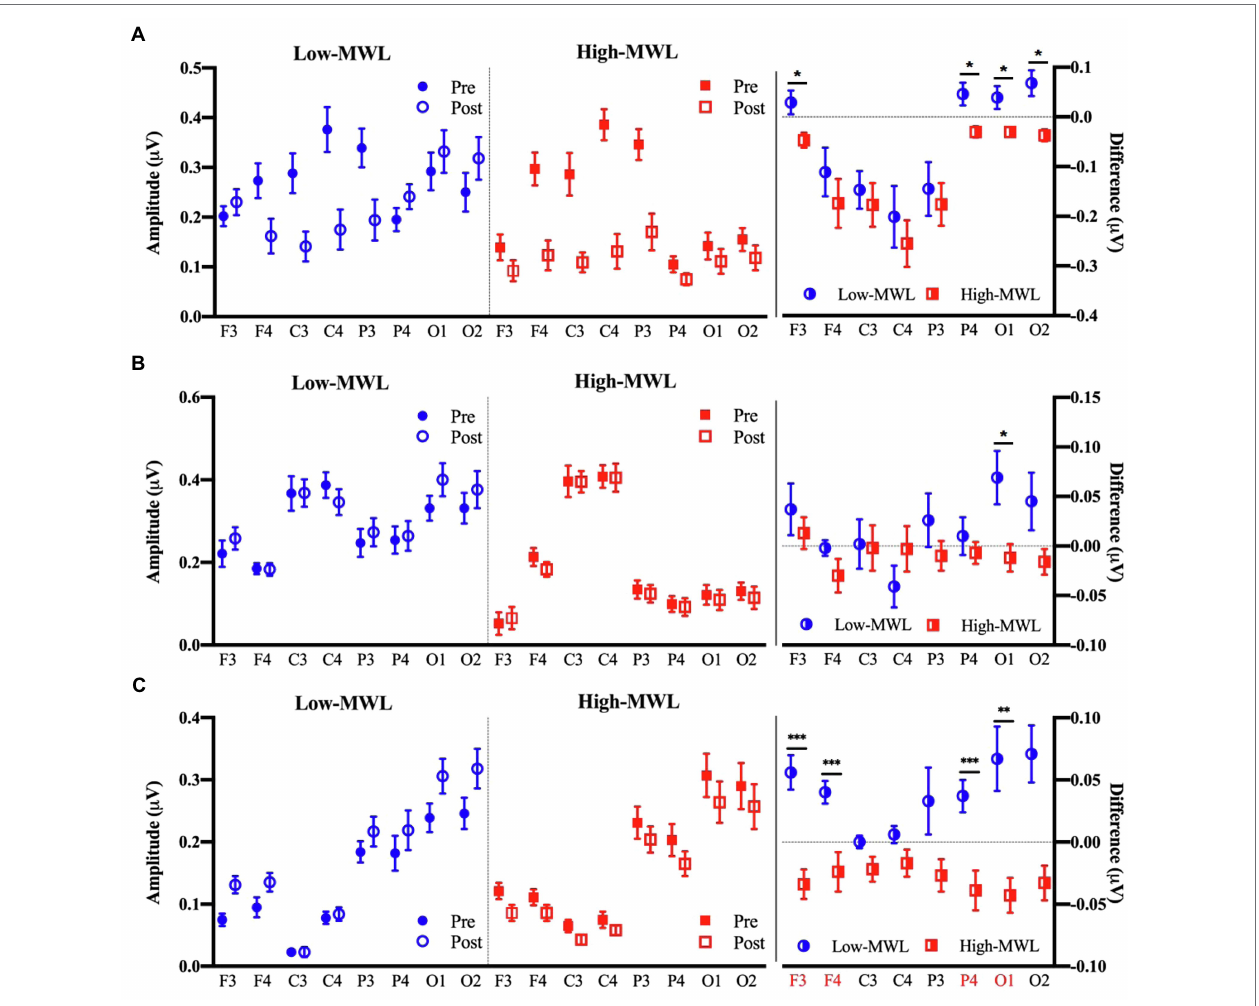
FIGURE 6 | Comparison of the P600 amplitude in ERP between the low- and high-MWL conditions. (A) ERP T condition. (B) ERP HEP condition. (C) ERP A-HEP condition (paired t -test; * p < 0.05, ** p < 0.0031, and *** p <